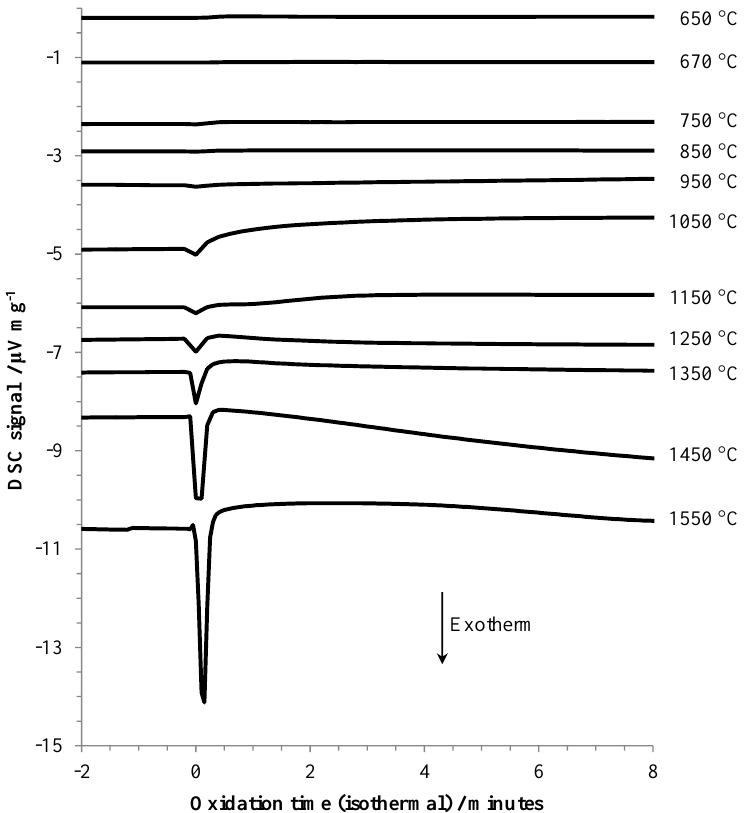
Figure 2. DSC results for aluminum heated under argon to the indicated temperature, then exposed to air (at t = 0).